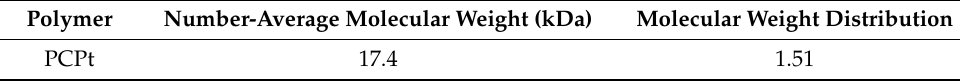
Figure 1. ( a ) 1 H NMR spectrum of PCPt (400 M, DMSO-d 6 ), ( b ) GPC curve of PCPt, and ( c ) GPC curve of PCPt treated with 10 mM SA for 12 h. Table 1. GPC analysis of mPEG-poly(platinum-co-Cur)-mPEG (PCPt).